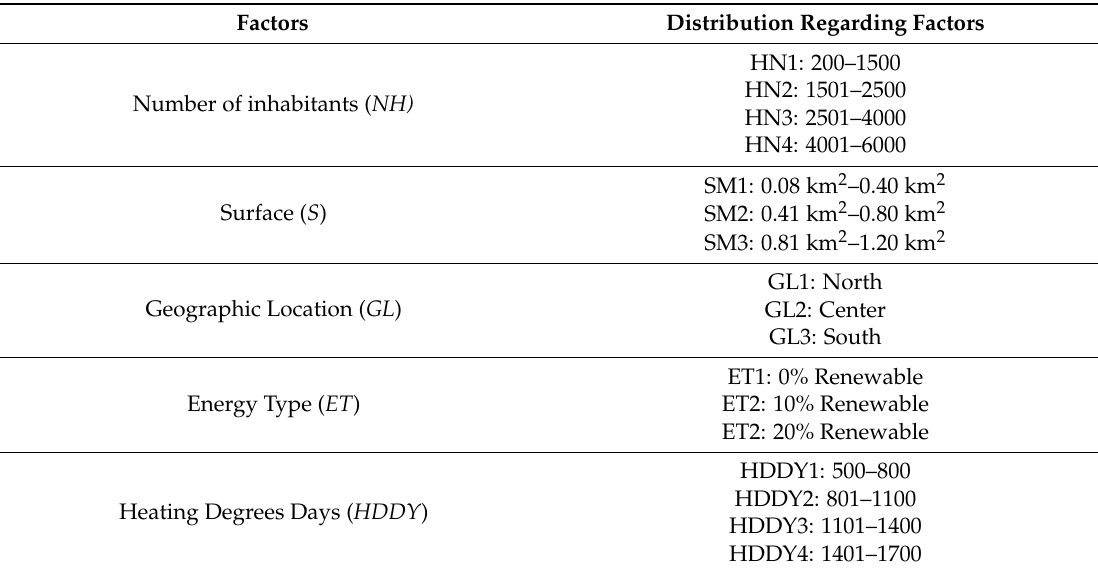
Table 2. Distribution regarding